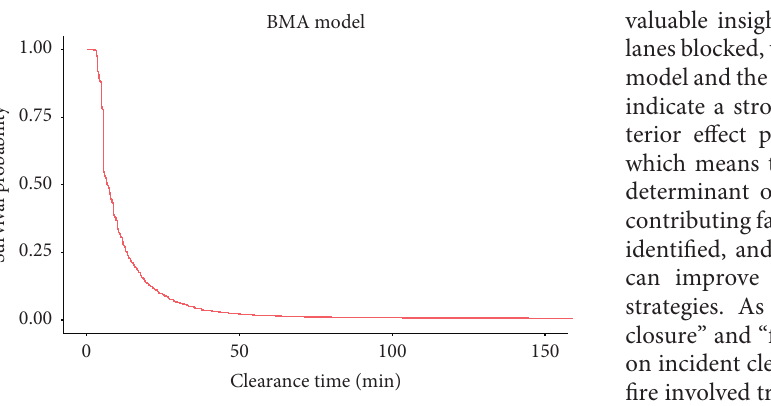
Figure 1: Estimated survival probability for the BMA model.